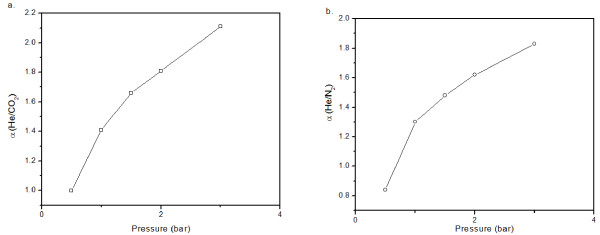
He/CO2selectivity (a) and He/N2selectivity (b) as a function of the applied pressure at 100°C.